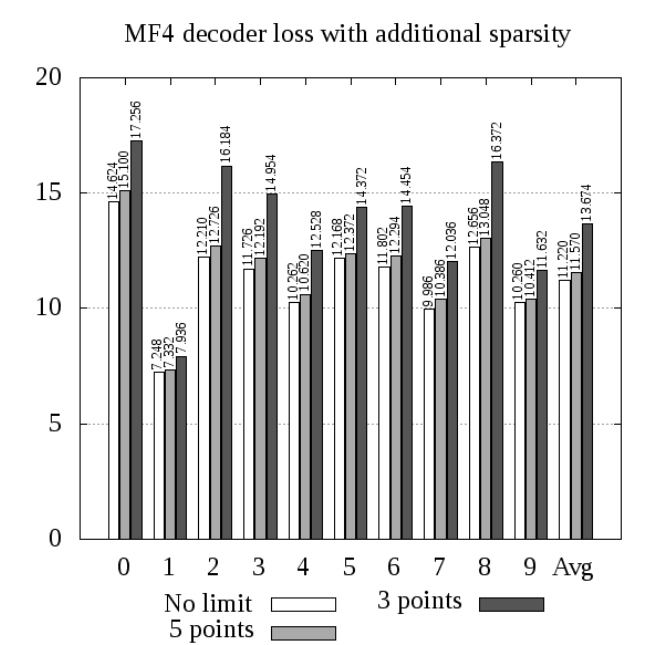
Figure 4. The pretrained decoder from the MF4 model can be used either with the original data without a specific limit of non-zero elements in the encoding, or with modified encodings, where each matrix contains up to 3 or 5 non-zero elements. The plot presents decoding errors for images showing individual digits and for the whole test